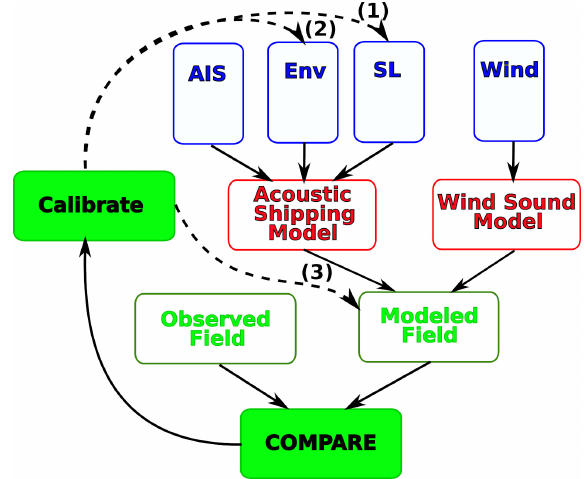
Figure 6. Continuous noise low-frequency field calibration by acting on: (1) the assumed ship source level, (2) environmental properties’ inputs to the acoustic model, or (3) directly on the model distribution output (AIS: Automatic Identification System; Env: environmental information; SL: source level; Wind: wind distribution